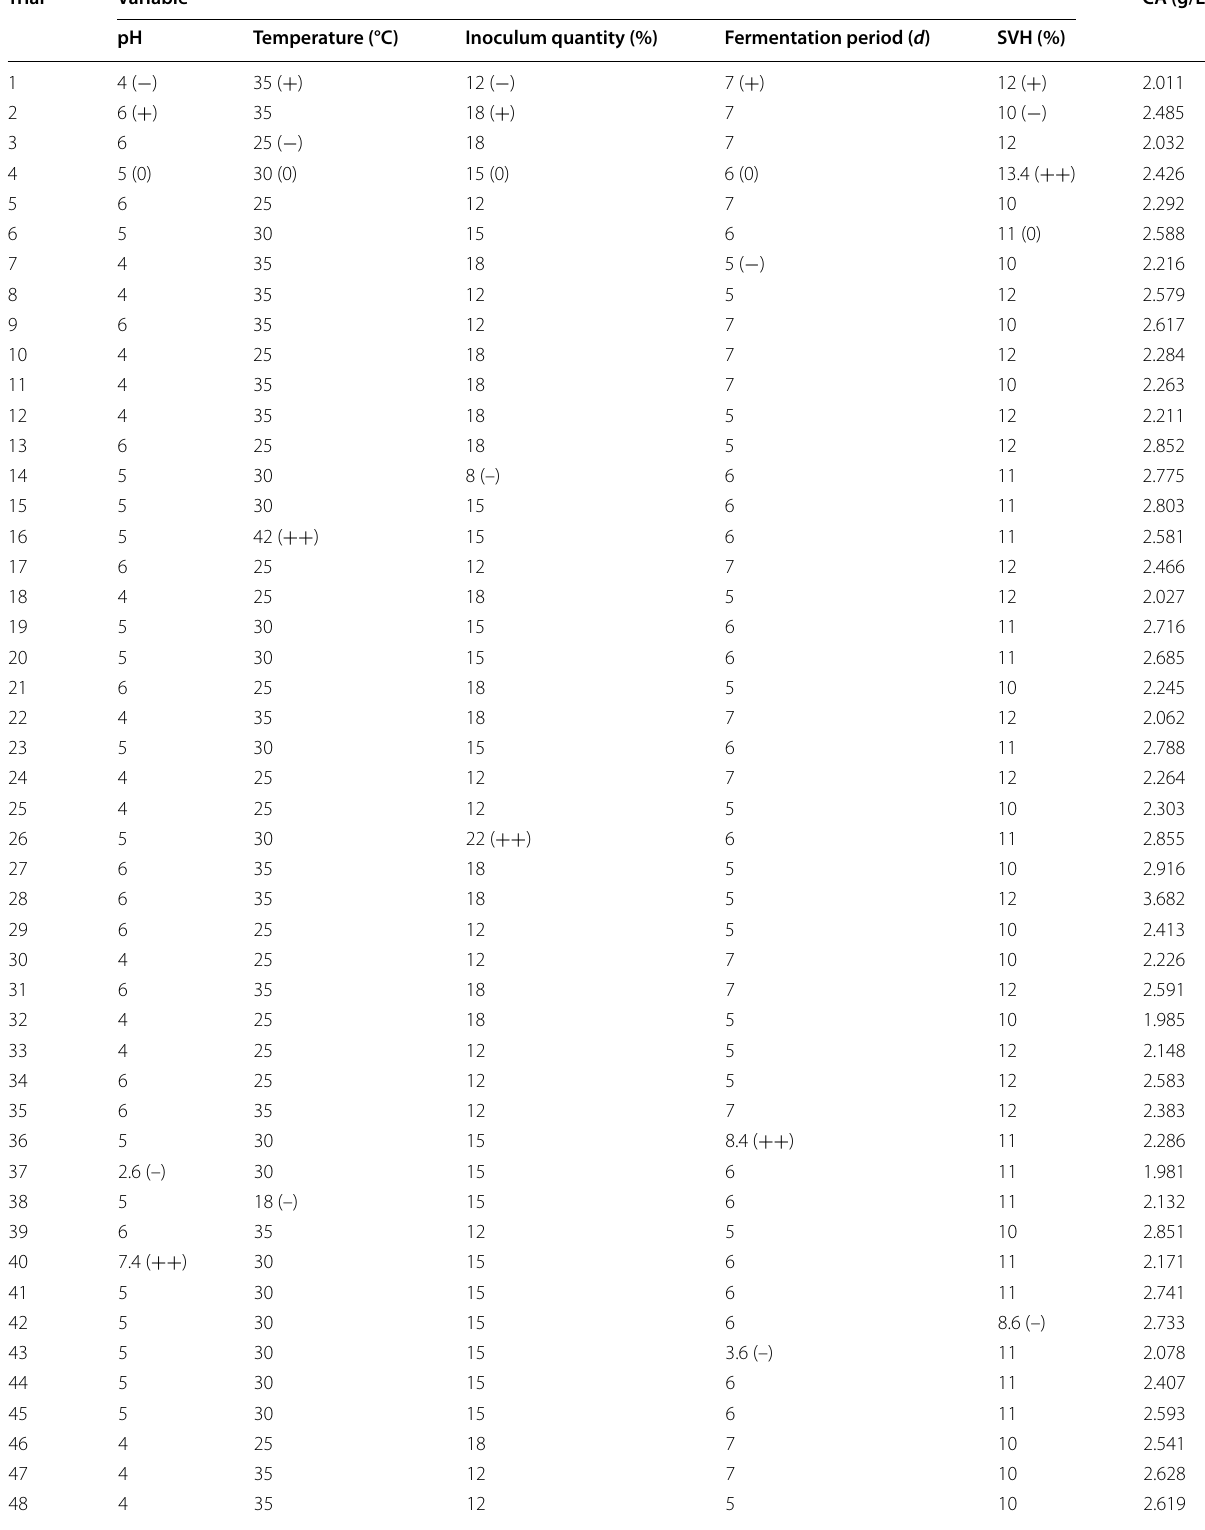
Table 2 Independent variables and levels of variation in